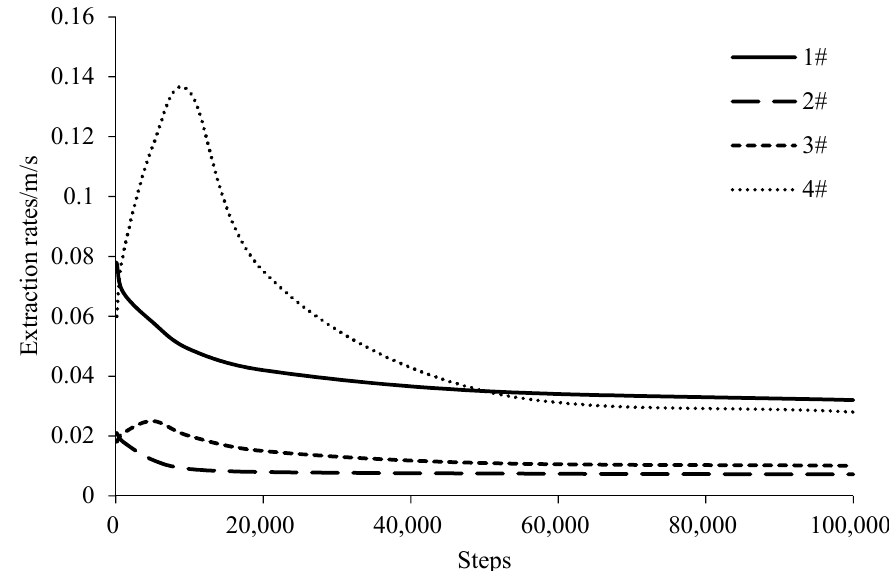
Figure 10. Gas flow rates variation curve of the monitoring points.